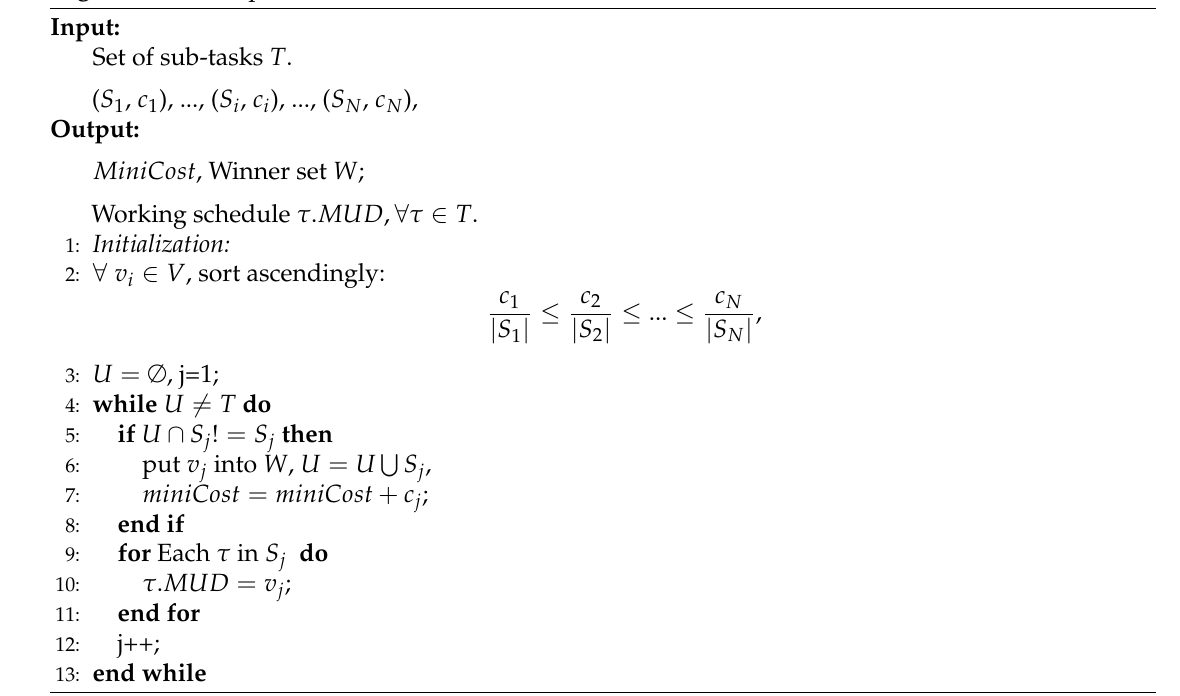
Algorithm 2 Suboptimal Winner Set Selection